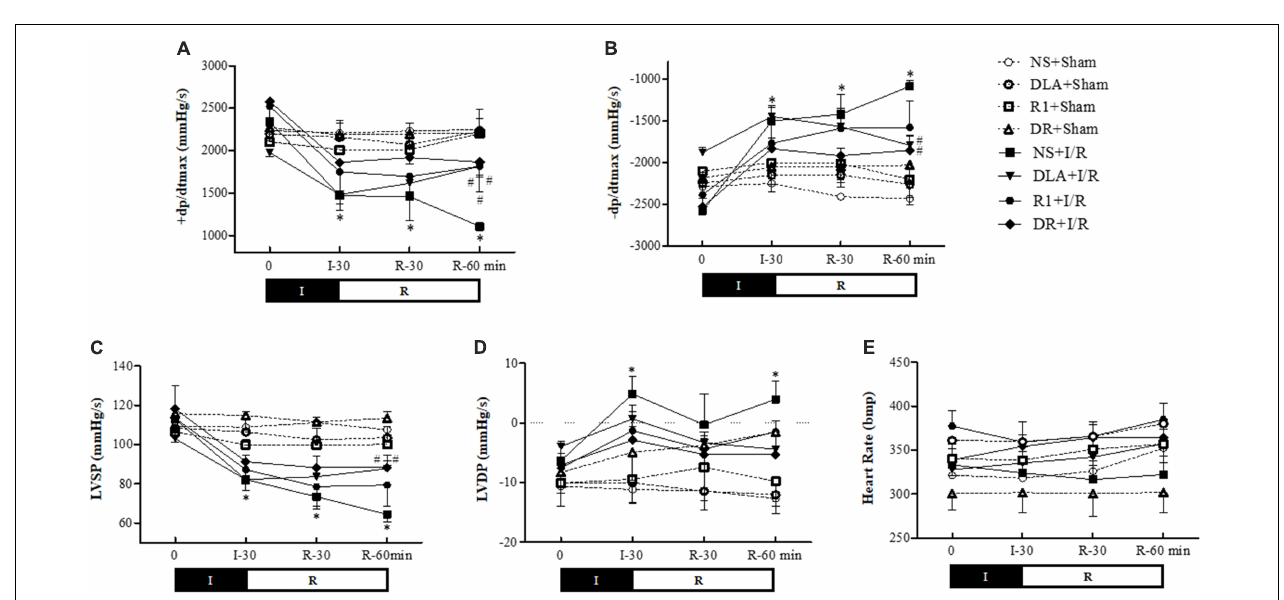
FIGURE 3 | The effect of DLA, R1, and DR pretreatment on the diameter of vessels and red blood cell velocity’s (RBC) velocity in coronary venules in rats subjected to I/R. (A) The time course of change in the diameter of vessels. (B) The time course of change in RBC’s velocity in coronary venules. Data are mean ± SEM (n = 6). I, ischemia phase; R, reperfusion phase. * p < 0.05 vs. NS + Sham group; # p < 0.05 vs. NS + I/R group; & p < 0.05 vs. DLA + I/R group and R1 + I/R group.